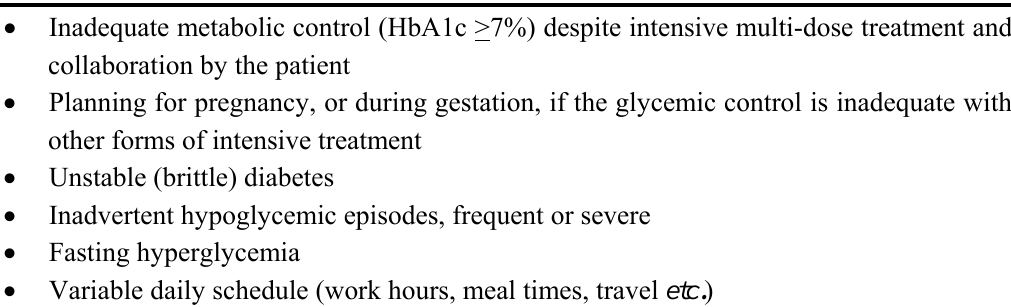
Table 3. Indications for the insertion of the CSII